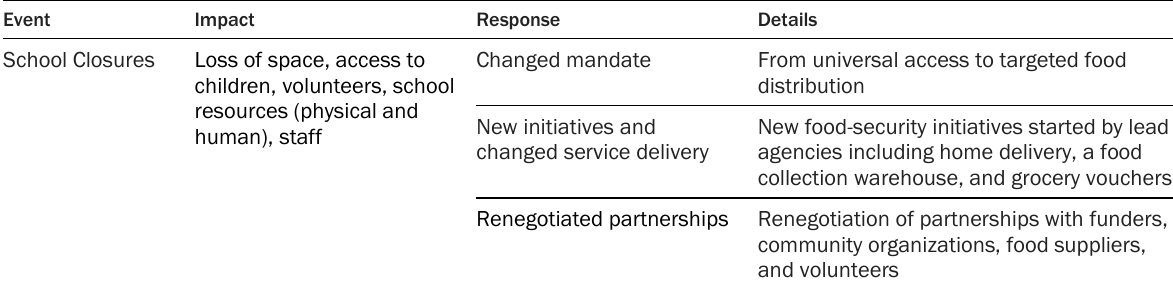
Table 3. Impact of COVID-19 on School Nutrition Programs Event